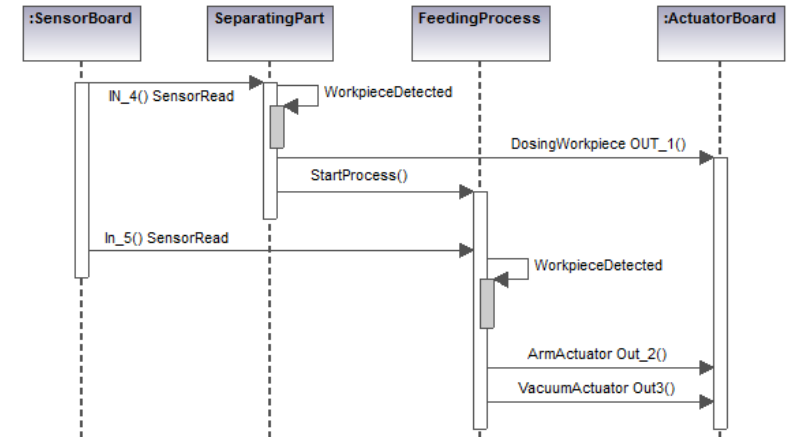
Figure 9. Distributing sequence